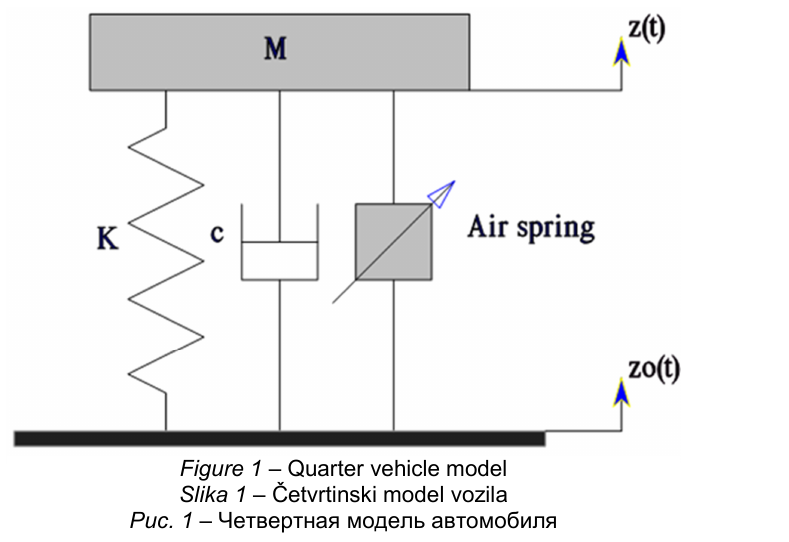
Figure 1 – Quarter vehicle model Slika 1 – Č etvrtinski model vozila Рис . 1 – Четвертная модель автомобиля